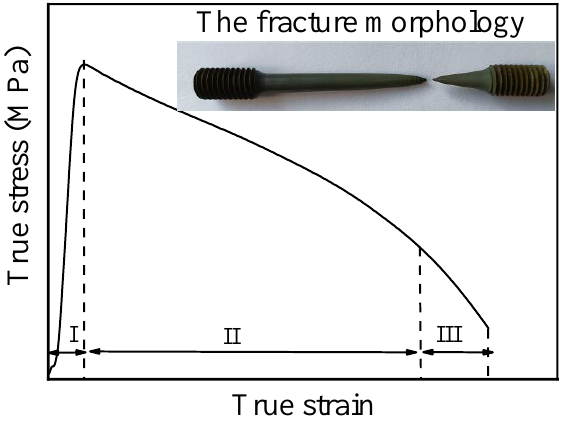
Figure 3. High temperature deformation characteristics.